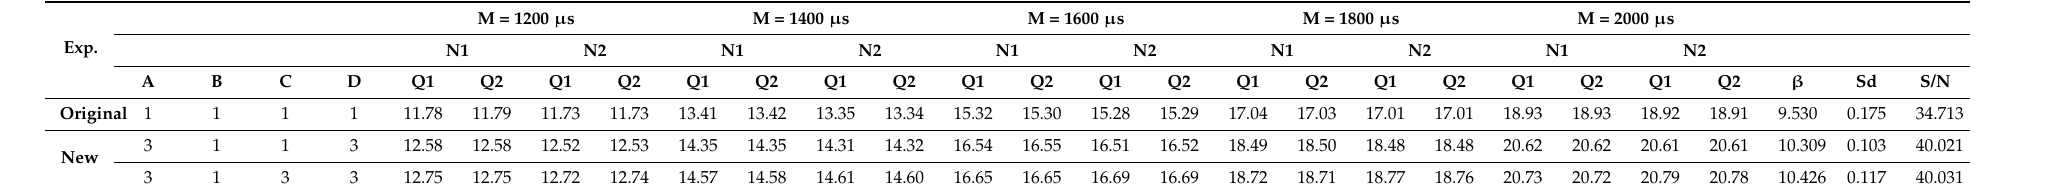
Table 3. Confirmation experiments for the original factory and new